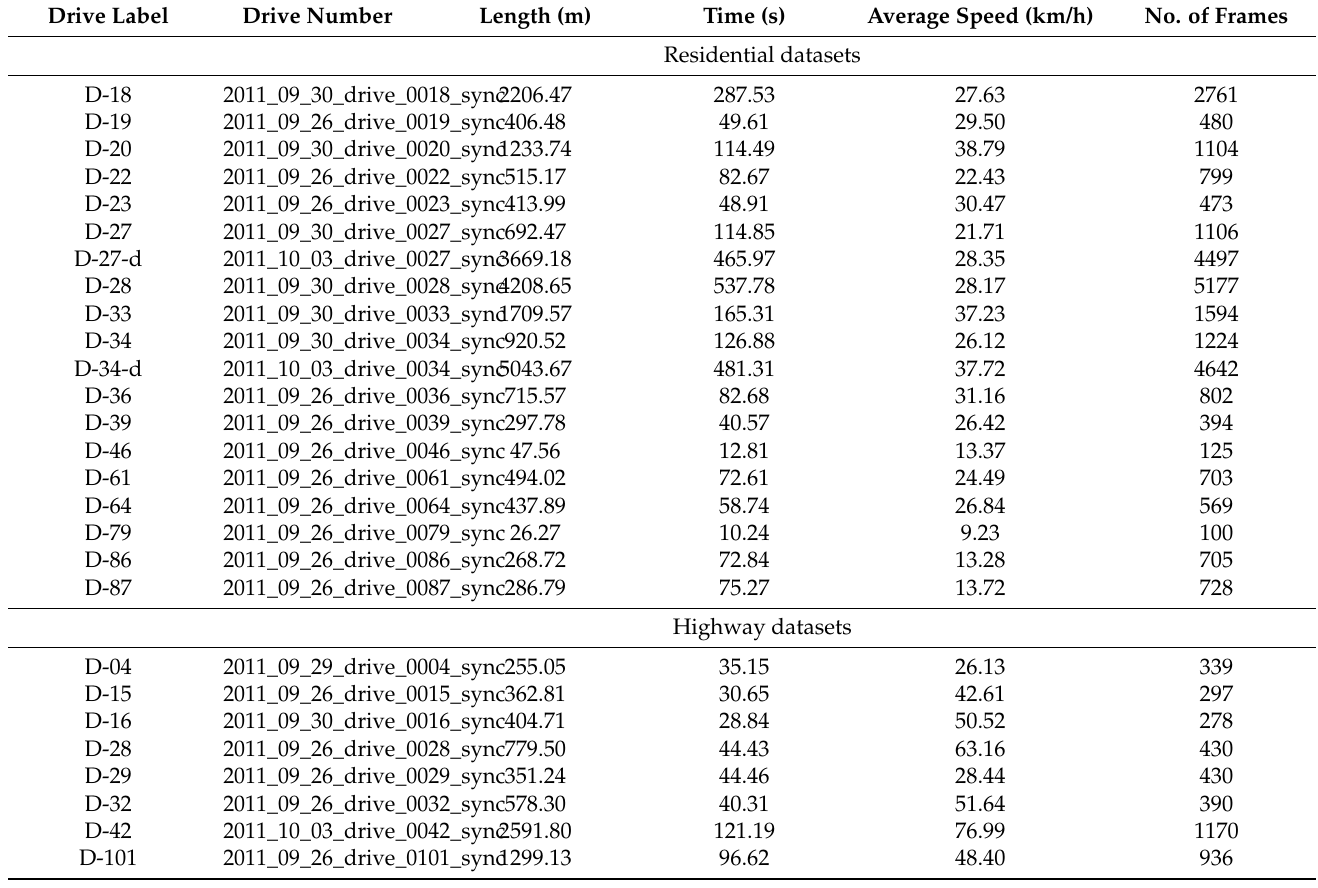
Table 1. Trajectory information for the KITTI datasets considered